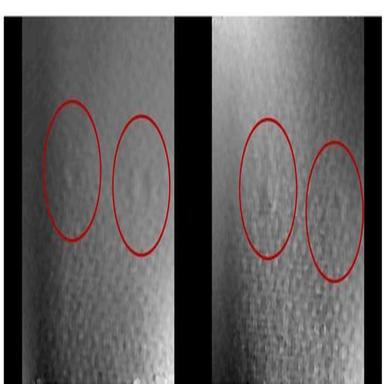
Laser shearography image, with location of detected defects.